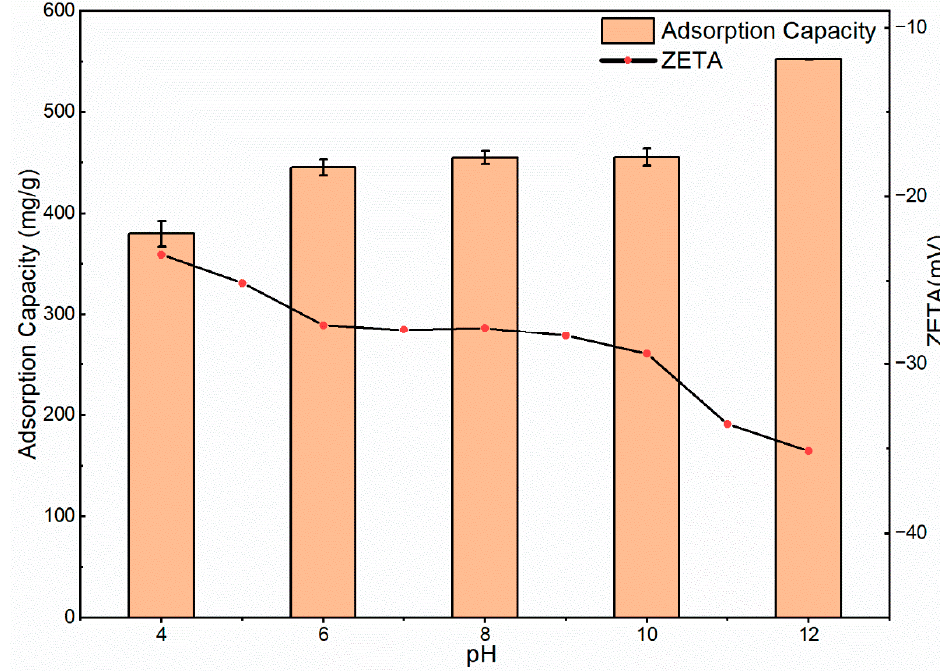
Figure 11. Zeta potential and adsorption of CN at different pH levels.